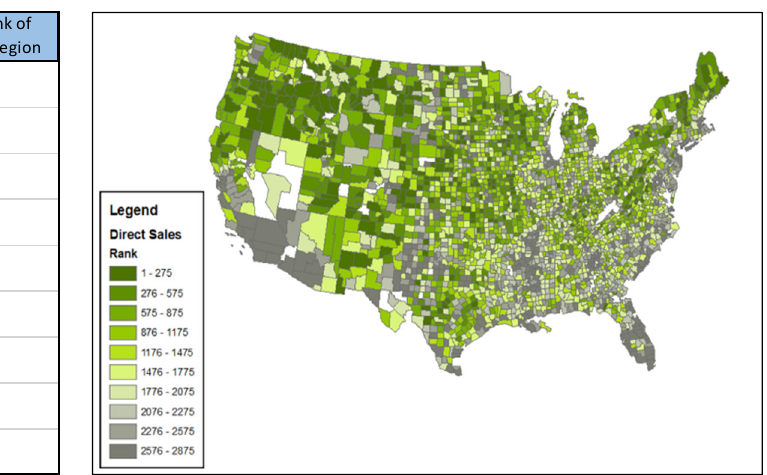
Map 10. Direct Sales Rank,